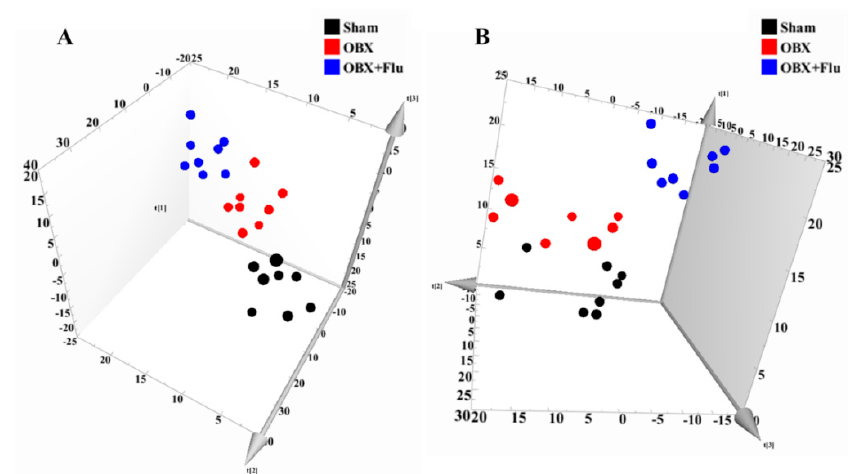
Figure 4. 3D-PCA score plots of hippocampus samples from sham (black), OBX (red), and OBX + Flu groups (blue) assayed by the UPLC-QTOF-MS in positive ( A ) and negative ( B ) ionization modes, respectively ( n = 8). Flu, fluoxetine. OBX, olfactory bulbectomy.